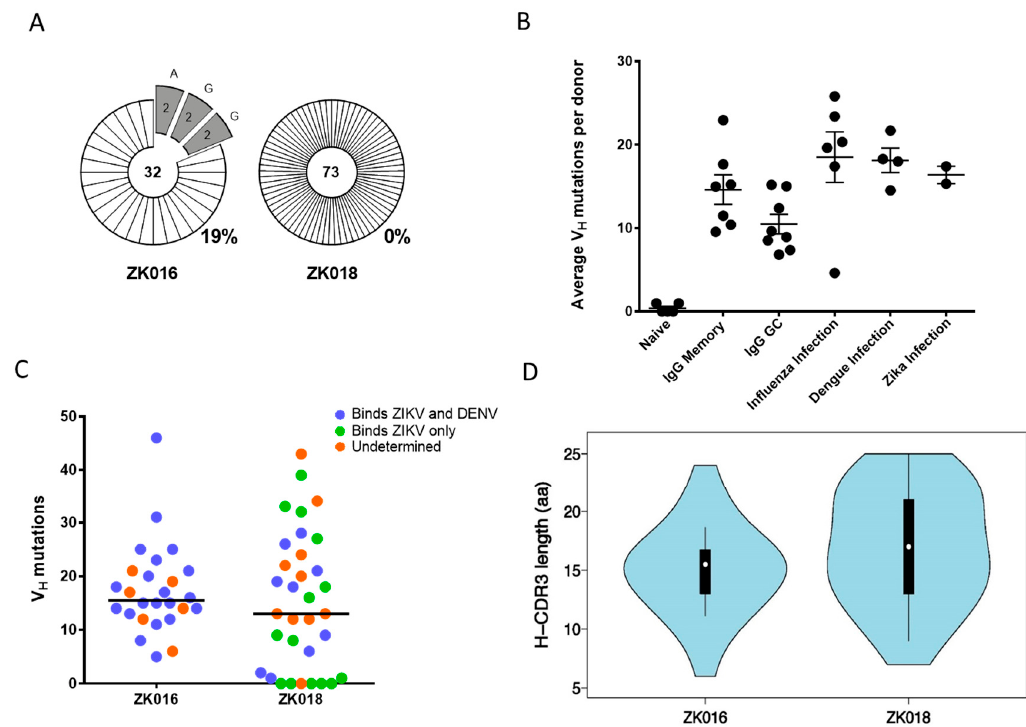
Figure 3. Clonality and mutational characteristics of the ZIKV plasmablast response. ( A ) Clonal relatedness of heavy chain variable region (VH) sequences amplified from patient plasmablasts. The number at the center of each pie chart is the total number of heavy chain sequences analyzed, including unpaired VH sequences that were not pursued for mAb synthesis. The numbers within the pie slices denote the number of clones with a shared VH rearrangement and junction. The percentage of total clonal sequences per donor is shown to the bottom right of the pie charts. ( B ) Average per donor VH mutation frequencies of the two ZIKV patients compared to historical data. Each circle represents the average number of VH nucleotide mutations per donor. Somatic hypermutation frequencies in naive, memory and germinal center B cells, and peripheral B cells from influenza and dengue infected donors were derived from previously published data [33,42]. ( C ) The range of VH mutation frequencies in the two ZIKV patients. Each circle represents the number of VH mutations per mAb sequence. The binding specificities of the mAbs to ZIKV and DENV are color coded: Cross-reactive mAbs are shown in blue, ZIKV-reactive in green and mAbs of undetermined specificity in orange. ( D ) VH CDR3 amino acid length distribution of all mAb sequences per patient.